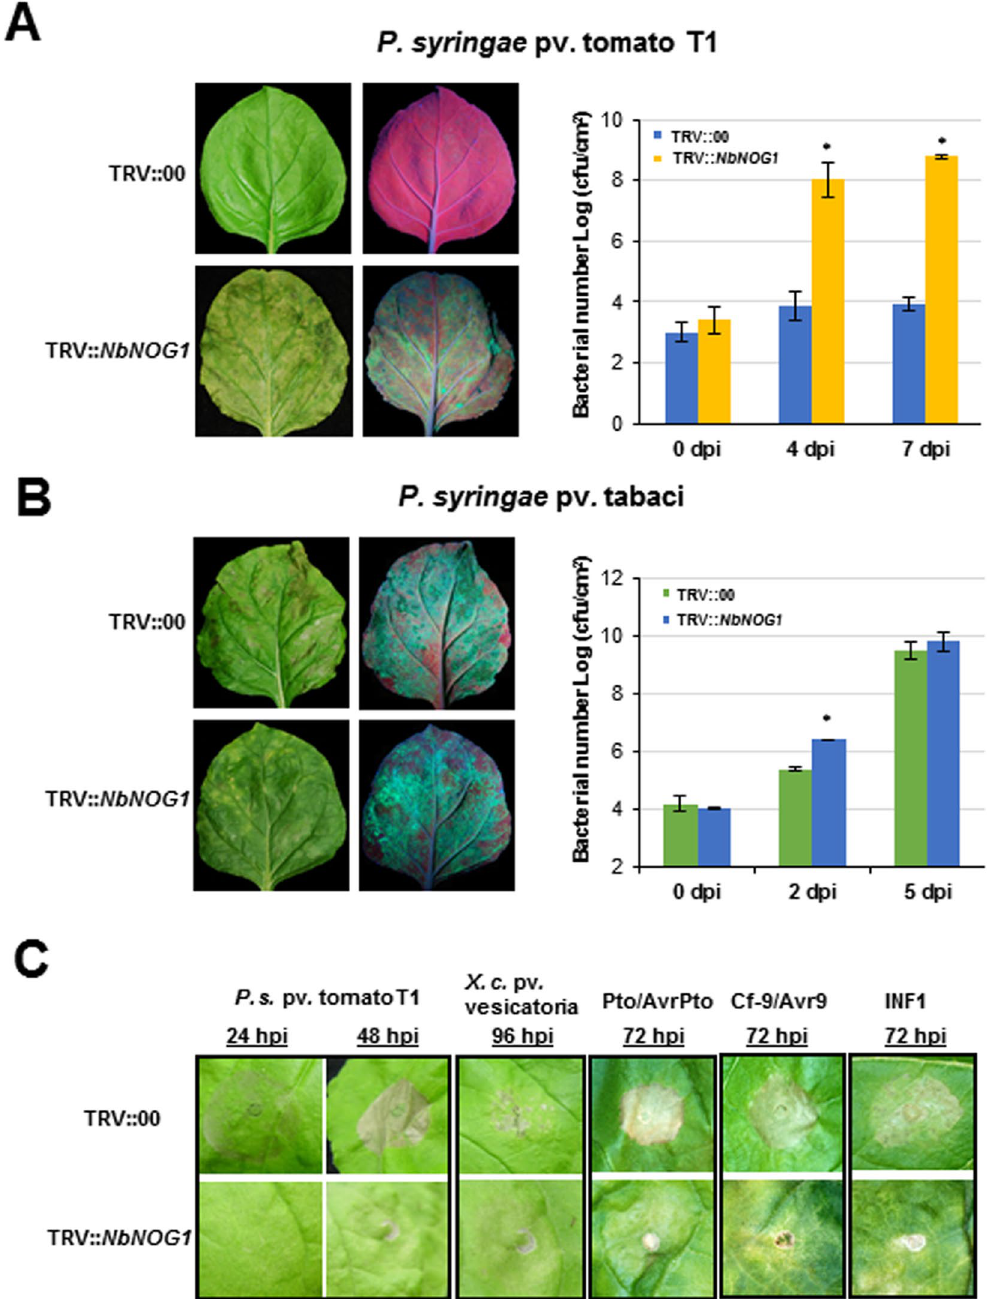
Figure 1. N. benthamiana NbNOG1 -silenced plants are compromised in nonhost resistance. ( A , B ) NbNOG1- silenced (TRV:: NbNOG1 ) and non-silenced control (TRV::00) N. benthamiana plants were vacuum-infiltrated with nonhost pathogen P. syringae pv. tomato T1 ( pDSK-GFP uv ) or host pathogen P. syringae pv. tabaci ( pDSK- GFP uv ) to observe symptom development (left panels) or bacterial multiplication 3 days post-inoculation (dpi; right panels). An increase in GFP fluorescence associated with bacterial multiplication was observed in TRV:: NbNOG1 plants but not in the TRV::00. To monitor bacterial multiplication in TRV:: NbNOG1 and TRV::00, N. benthamiana plants were vacuum-infiltrated with P. syringae pv. tomato T1 ( A ) and P. syringae pv. tabaci ( B ) and bacterial multiplication was quantified at various dpi as indicated. Bars represent means and standard deviations for three independent experiments. Asterisks above bars indicate statistically significant difference between NbNOG1- silenced plants and control (Student’s t -test P < 0.05). ( C ) HR was observed between NbNOG1- silenced and control N. benthamiana plants. Plants were syringe-infiltrated with P. syringae pv. tomato T1 or X. campestris pv. vesicatoria (1 × 10 6 CFU/ml) or Agrobacterium strains for transient expression of Pto and AvrPto , or Cf-9 and Avr-9 , or INF1 . Agrobacterium strain GV2260 with empty vector (EV) was used as a control. HR was observed at different hours post inoculation (hpi). This experiment was repeated at least three times and showed similar results. Each experiment had five